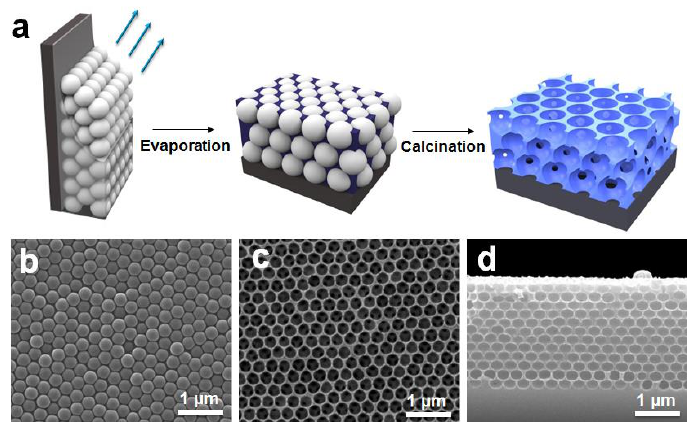
Figure 1. ( a ) Schematic illustration showing fabrication procedure of inverse opal (IO) nanostructure. SEM images of ( b ) the top surface of opal; ( c ) the top surface of the IO nanostructure; and ( d )